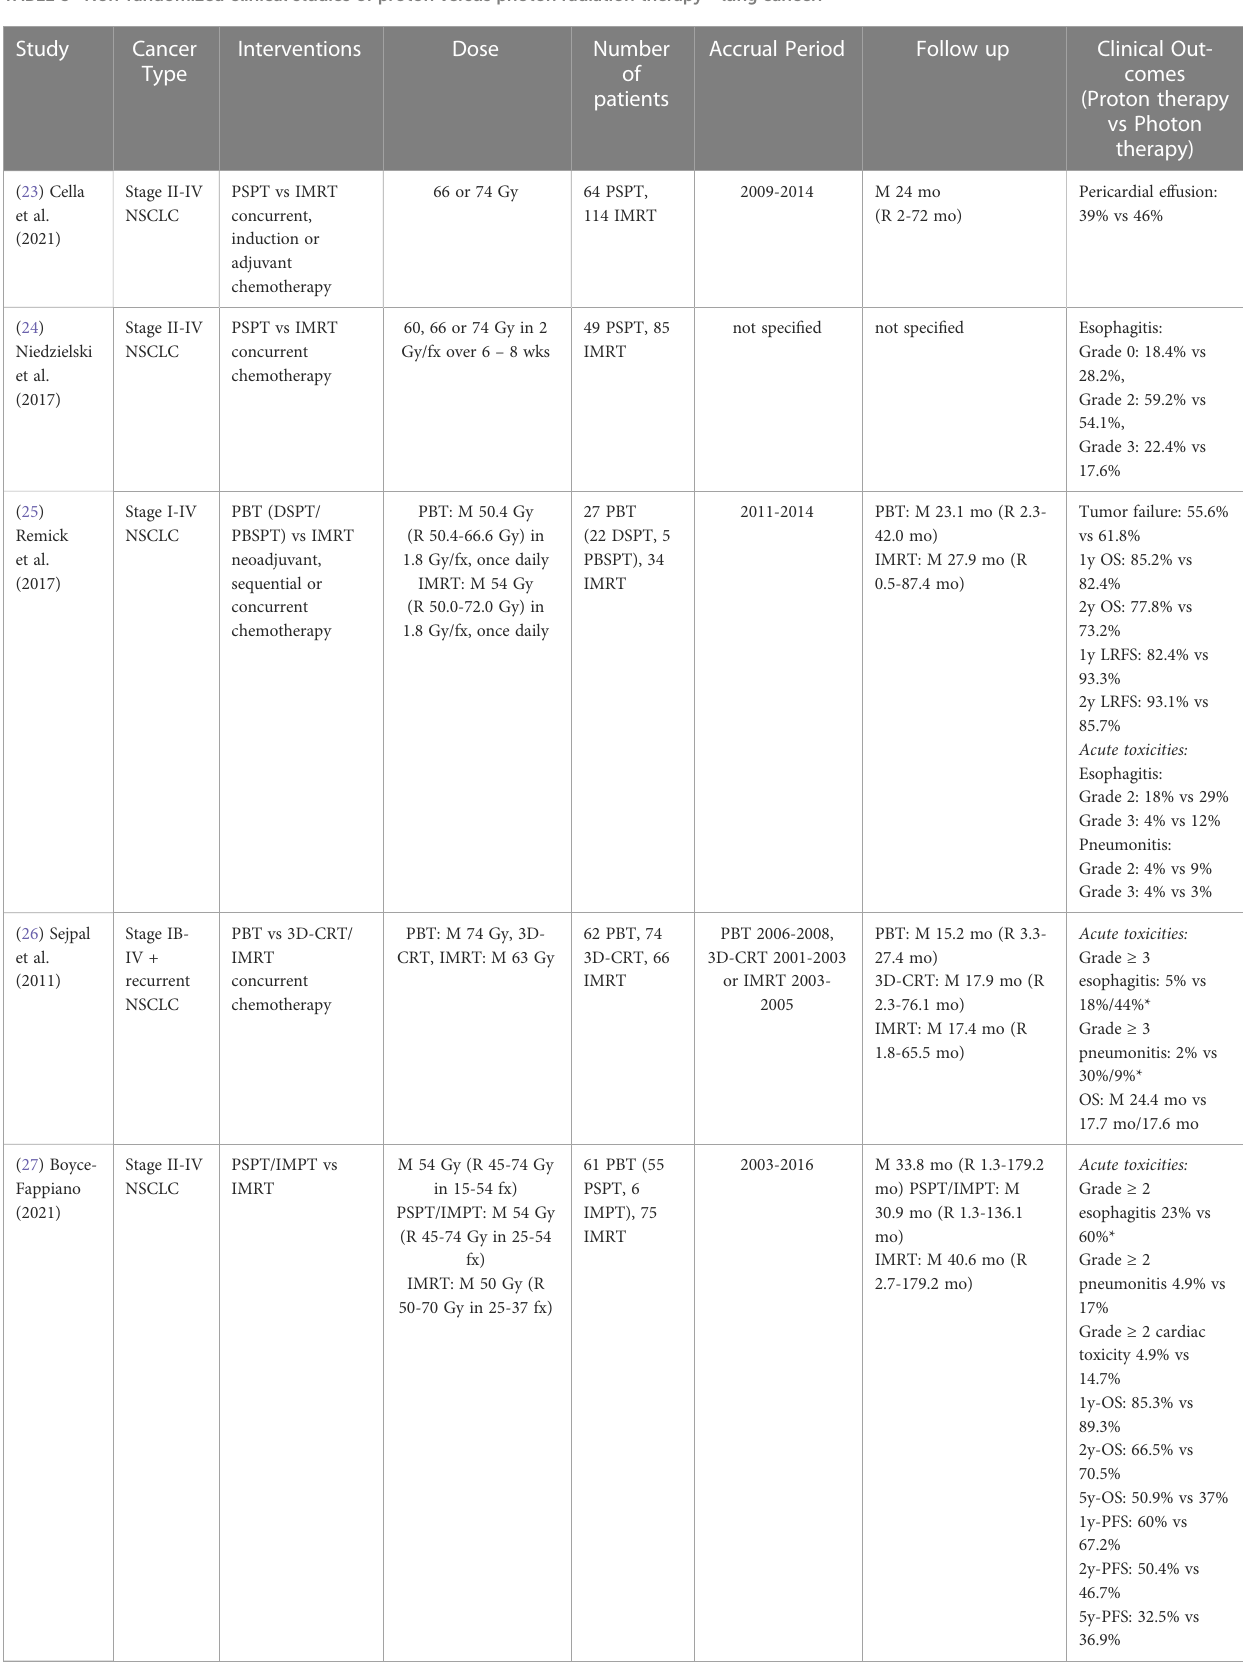
TABLE 3 Non-randomized clinical studies of proton versus photon radiation therapy - lung